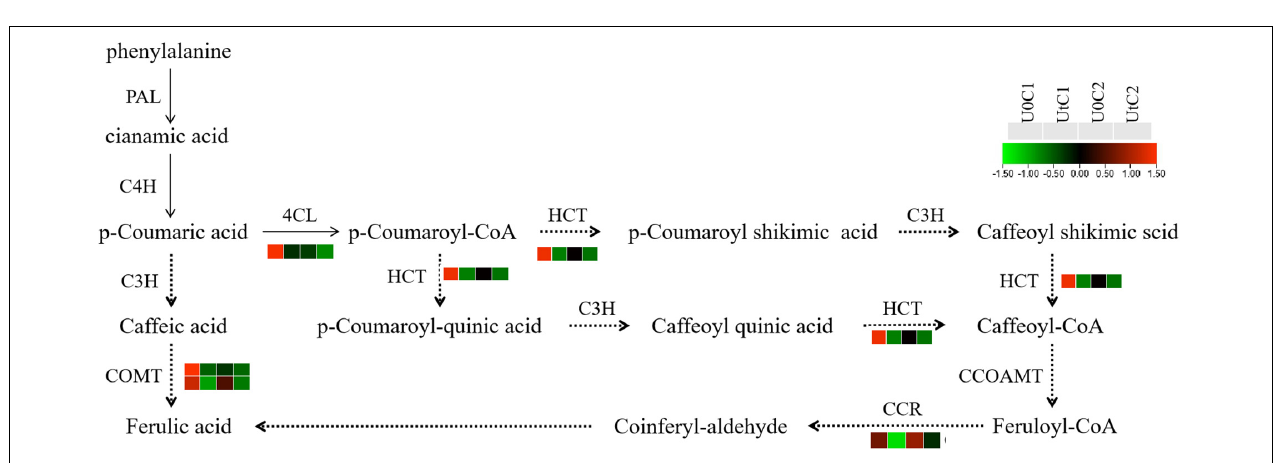
FIGURE 12 | Heatmap of differentially expressed genes (DEGs) related to plant hormone signal transduction of Mingui 1 and Mingui 2. Heat maps were drawn using log2-transformed FPKM values.